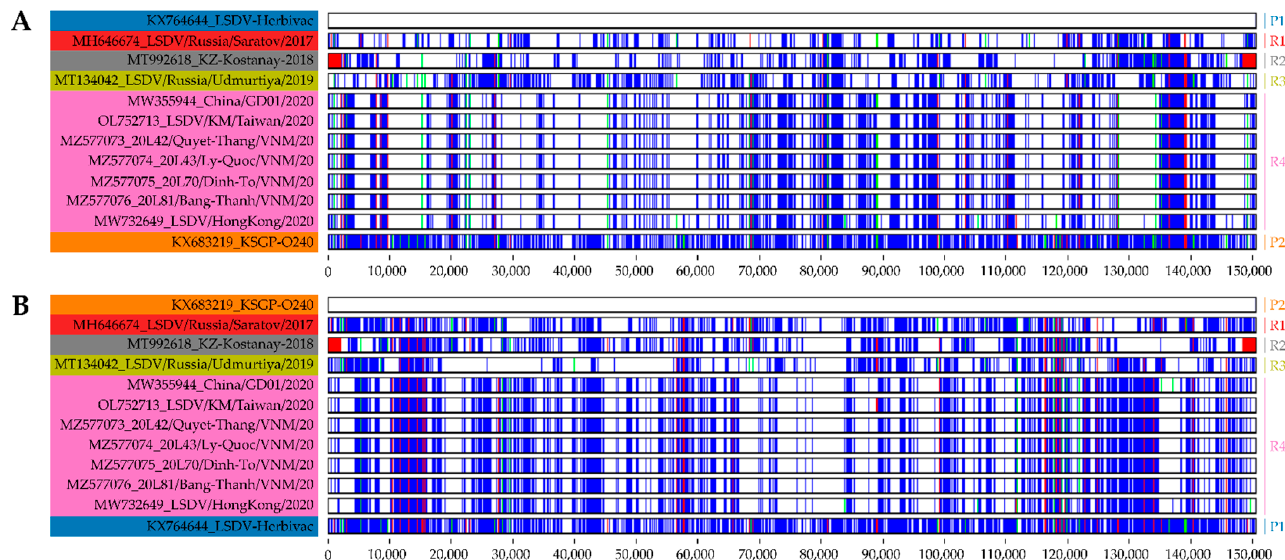
Figure 2. Visual summary of the genomes of the vaccine-like recombinant strains and their putative parental strains. Each panel shows a base-by-base comparison of the different sequences with the top sequence that served as the reference. The recombinant strains were compared to both a Neethling-based vaccine strain ( A ) and a KSGP-based vaccine strain ( B ). The following colouring scheme was used: perfect match (white), SNP (blue), deletion (red) and insertion (green). P1: parent 1, P2: parent 2, R1: recombinant group 1, R2: recombinant group 2, R3: recombinant group 3, R4: recom- binant group 4.